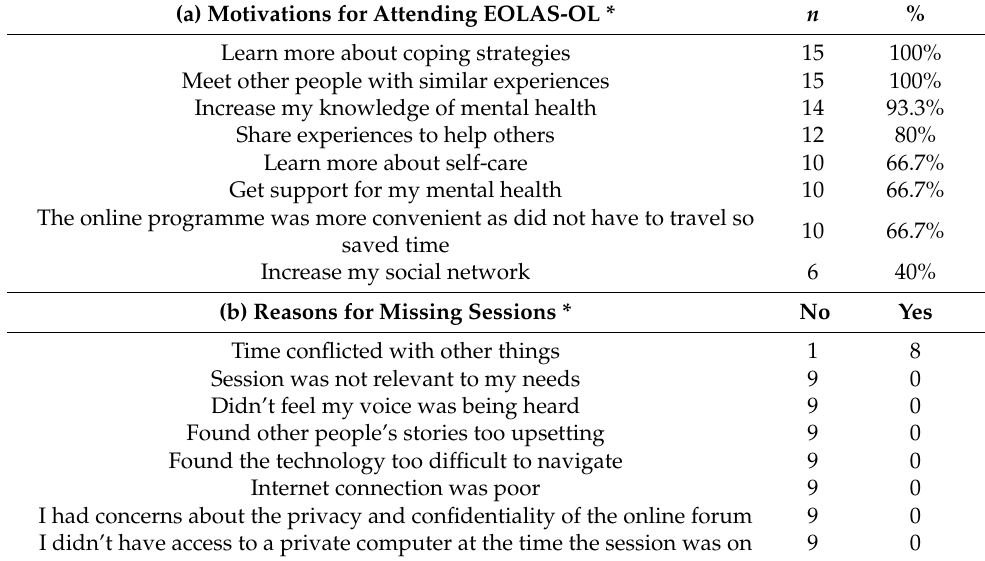
Table 2. Motivations and reasons for missing a session.